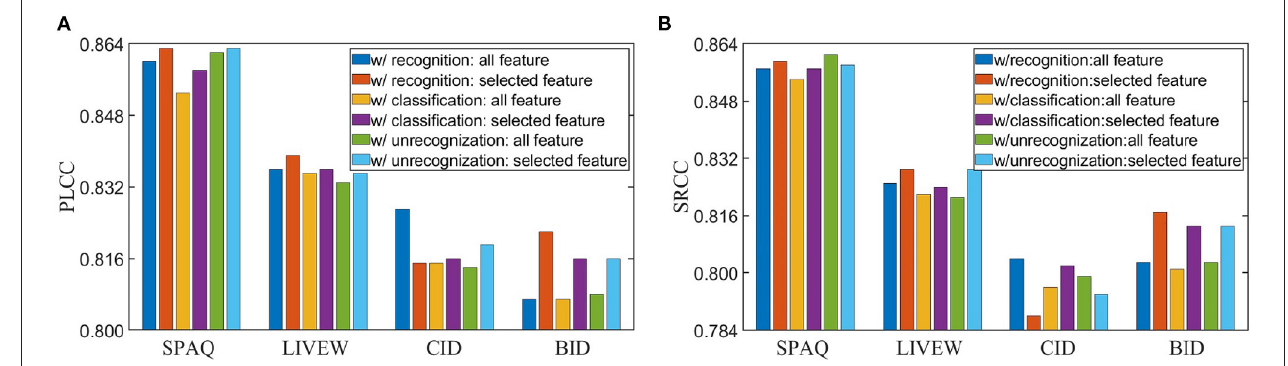
FIGURE 5 | Performance comparison for different tasks with/without feature selection strategy on KonIQ-10k. (A) Pearson’s linear correlation coefficient (PLCC) results. (B) Spearman’s rank order correlation coefficient (SRCC) results. The recognition and classification task utilize contribution-based strategy, and the unrecognizability task utilizes gradient-based strategy.